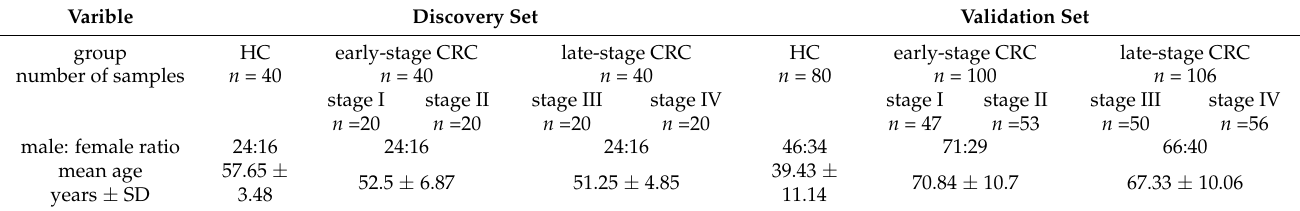
Table 1. Demographic information of patients with colorectal cancer (CRC) and healthy controls (HCs). Varible Discovery Set Validation